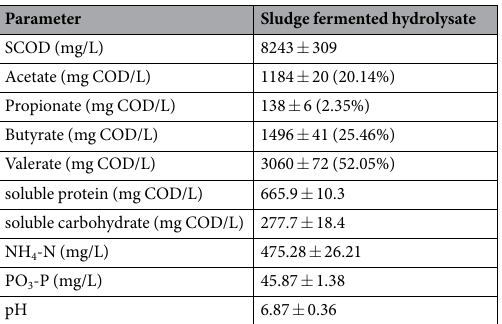
Table 1. Characteristics of the sludge thermophilic fermented hydrolysate collected at 60 h. The results are the averages and their deviations for different batches ( ≥ 6). The percentages in parentheses after the values of acetate, propionate, butyrate and valerate are on a COD basis in total VFAs.